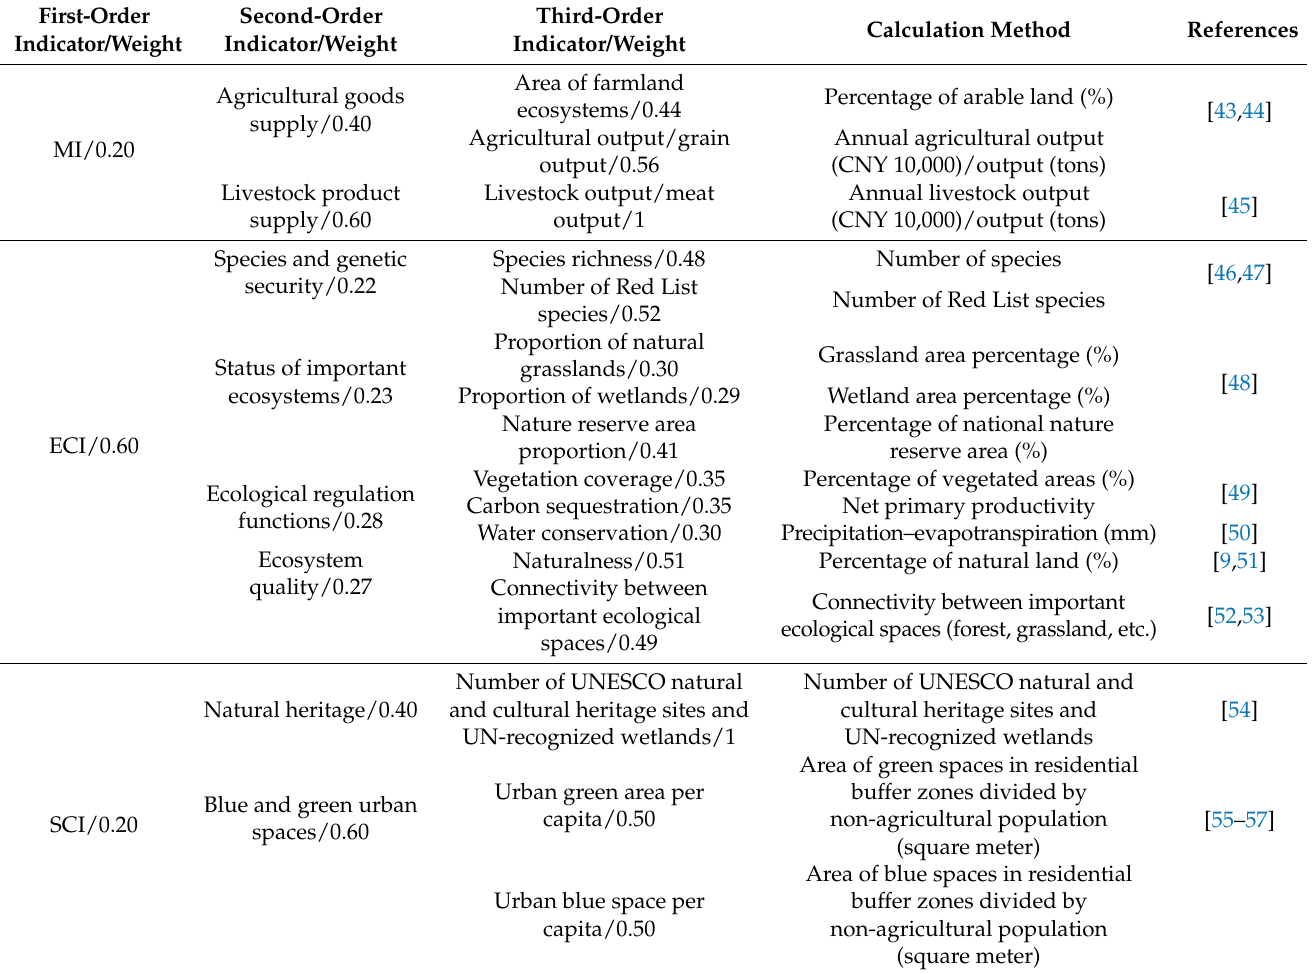
Table 1. System of indices for assessing the contributions of biodiversity to human well-being in the Sanjiangyuan area,